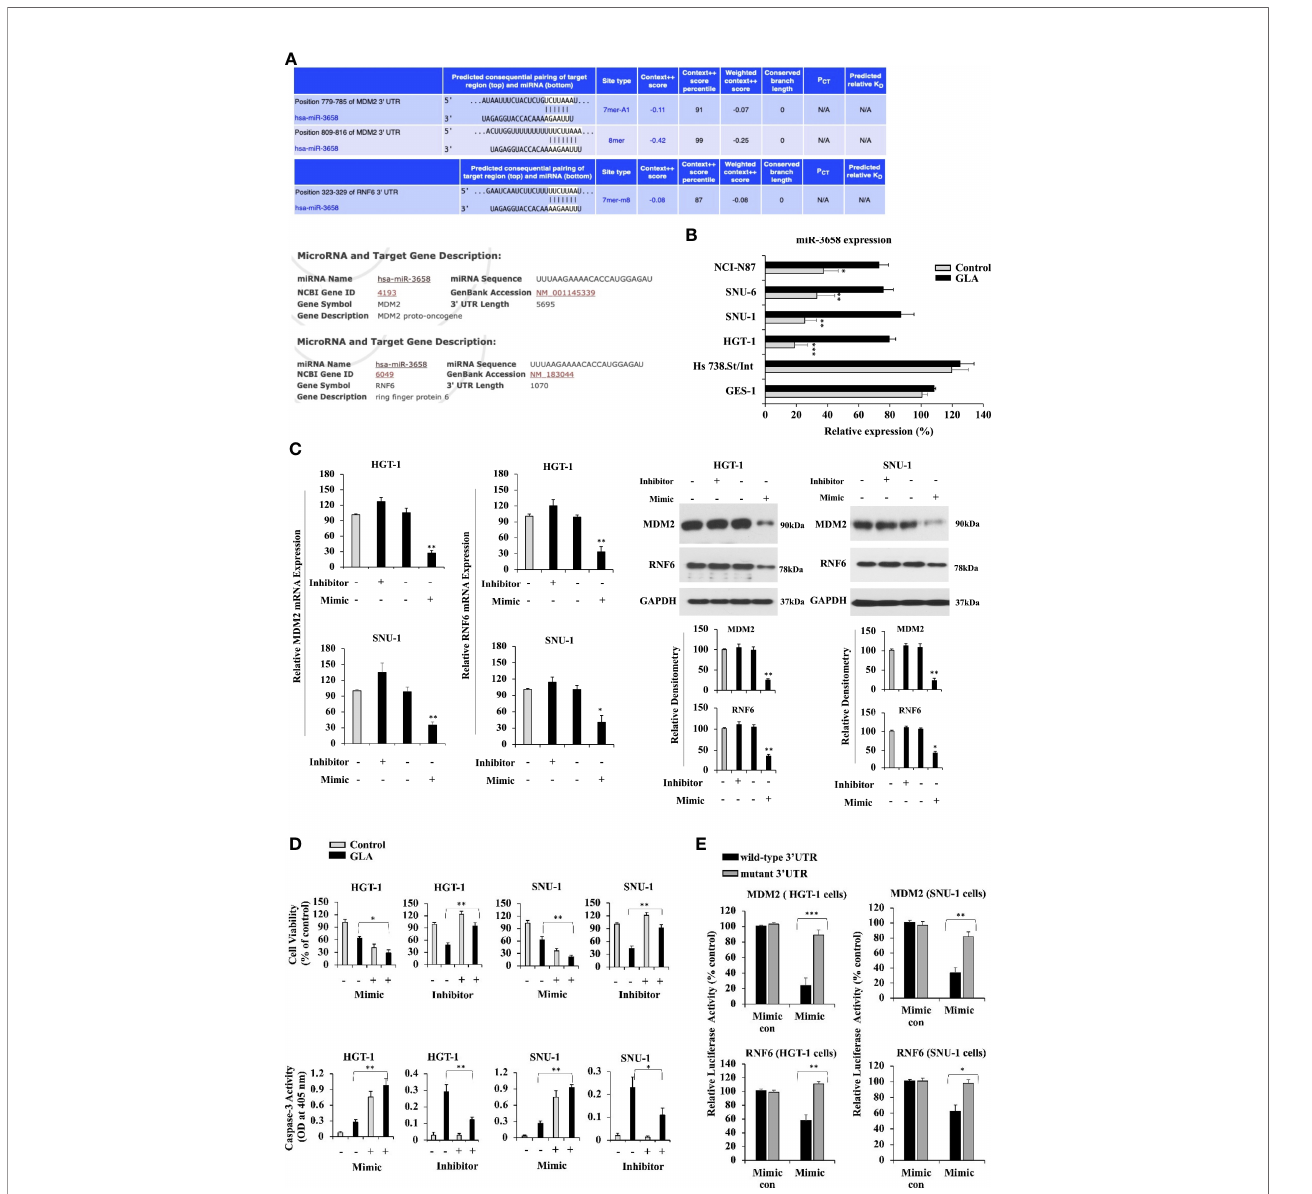
FIGURE 3 | MDM2 and RNF6 are the targets of miR-3658 that is upregulated by GLA in GC cells. (A) MDM2 and RNF6 were predicted as the targets of miR-3658 using prediction algorithms, TargetScan and miRDB. (B) miR-3658 expression in GES-1, Hs 738.St. Int, HGT-1, SNU-1, SNU-6, and NCI-N87 cells with or without GLA treatment (10 µM). (C) The effects of miR-3658 inhibitor and mimic on the expression of MDM2 and RNF6 at mRNA (left panel) and protein levels (right panel) and on (D) proliferation (upper panel) and apoptotic status (caspase-3 activity) (lower panel) of HGT-1 and SNU-1 cells. (E) Changes in the luciferase activity in HGT- 1 and SNU-1 co-transfected with PGL3 reporter vector containing either wild-type 3 ’ UTR or muted 3 ’ UTR of MDM2 or RNF6 and miR-3658 mimic or mimic control. The Western blot analysis was repeated three times. The data represented the mean ± SD (n=3). * p < 0.05, ** p < 0.01, *** p <